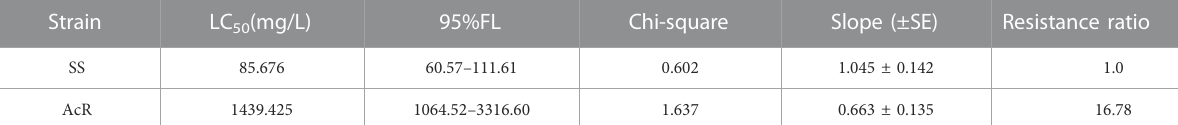
TABLE 2 Median lethal concentration (LC 50 ) of acetamiprid against M. usitatus .